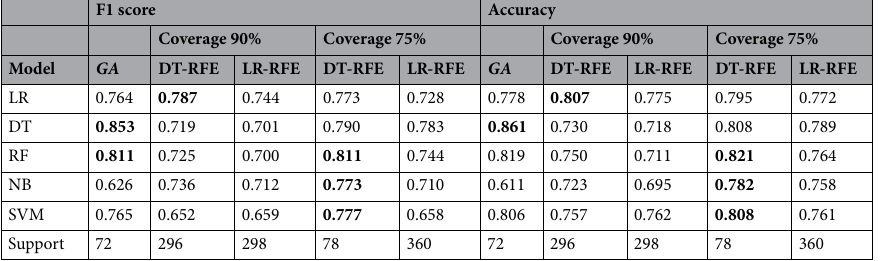
Table 4. Classification with leave-one-out cross validation on the second wave dataset (validation). Each row corresponds to a different model type. We compare models trained on variables selected by our feature selection method (GA) with those selected by the two recursive feature elimination algorithms with the two different coverage thresholds (DT-RFE, LR-RFE). The bold font identifies the models with best performance, for each of the different rows (i.e. for each predictive model type).